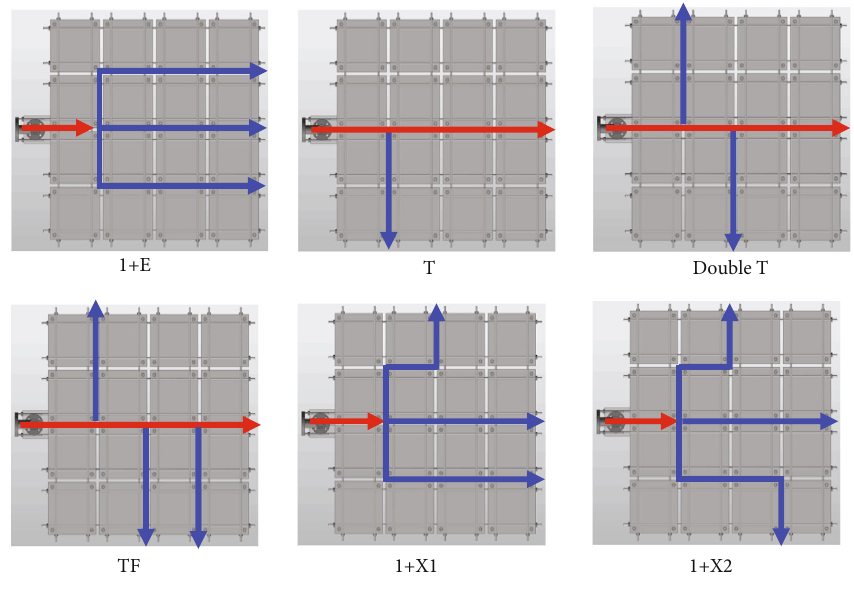
Figure 5: Di ff erent types of fractures models.